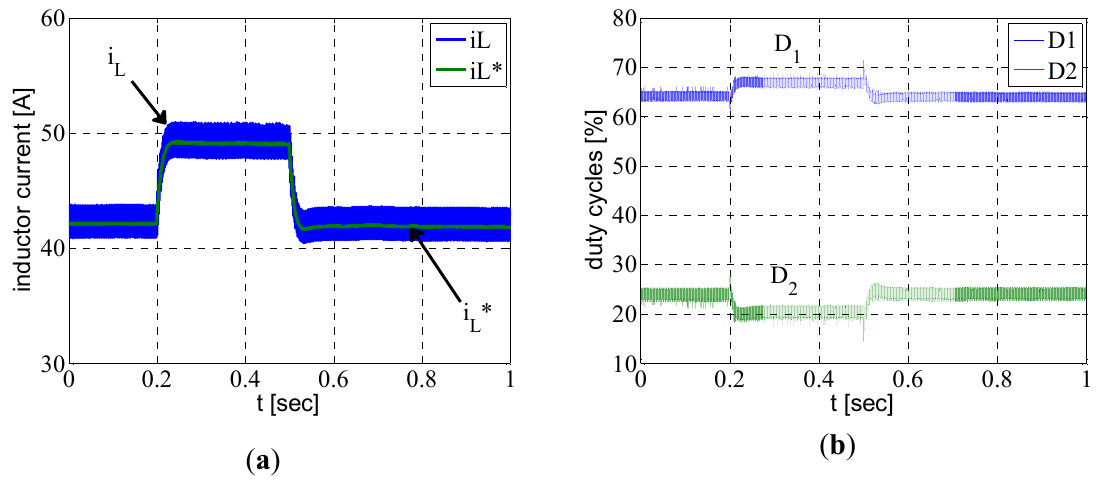
Figure 16. Load step variation results: ( a ) inductor current; ( b ) duty